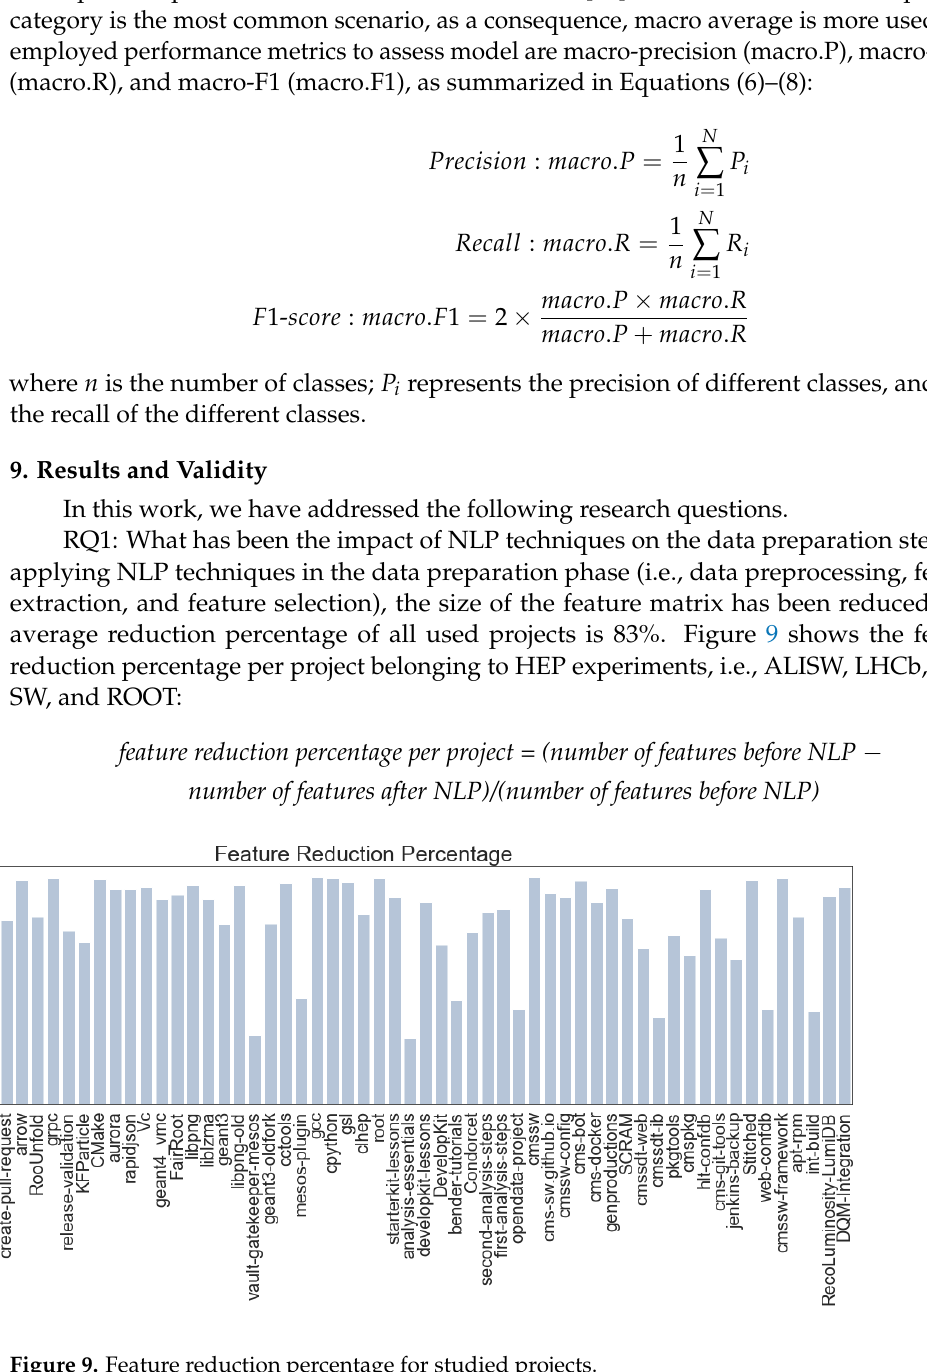
Figure 9. Feature reduction percentage for studied